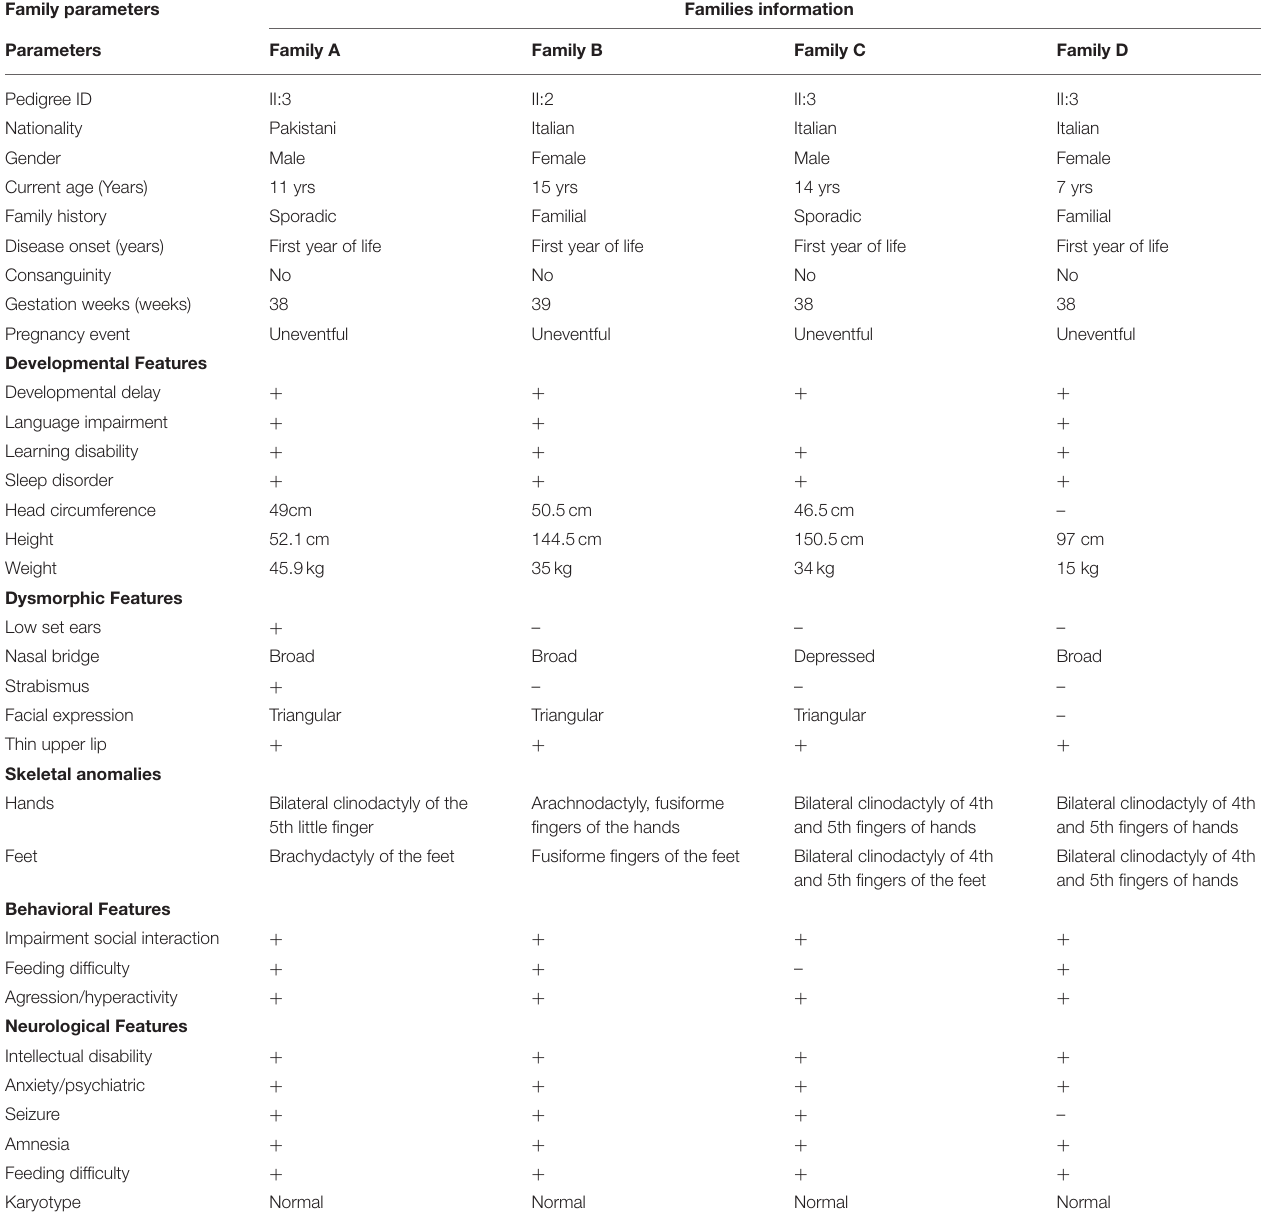
TABLE 1 | Clinical features of affected subjects from families A–D. Family